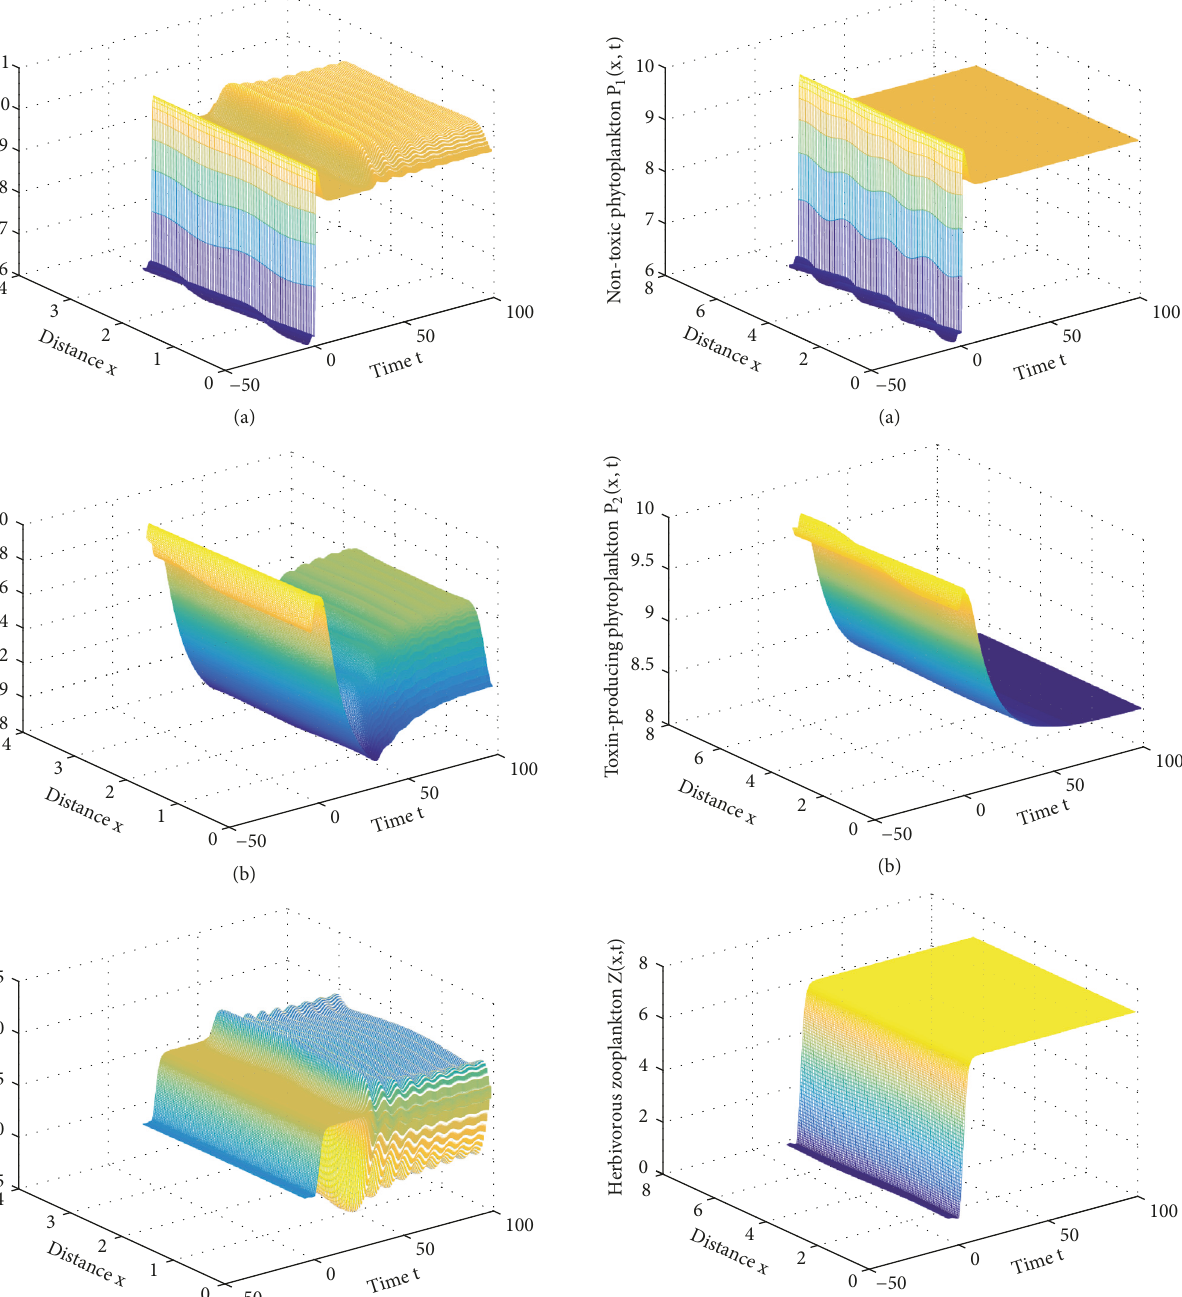
Figure 7: The equilibrium solution 𝐸 ∗ of (3) is asymptotically stable when 𝜏 = 5.42 and Ω = (0,2𝜋)